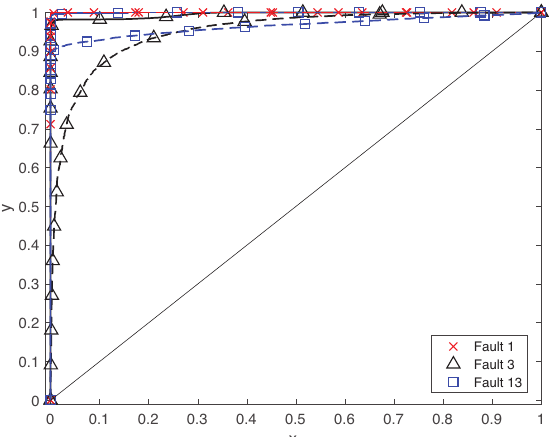
Figure 9. Receiver operating characteristic (ROC) curves using both LSTM and deep convolutional neural network (DCNN) for different faults 01,03,13.